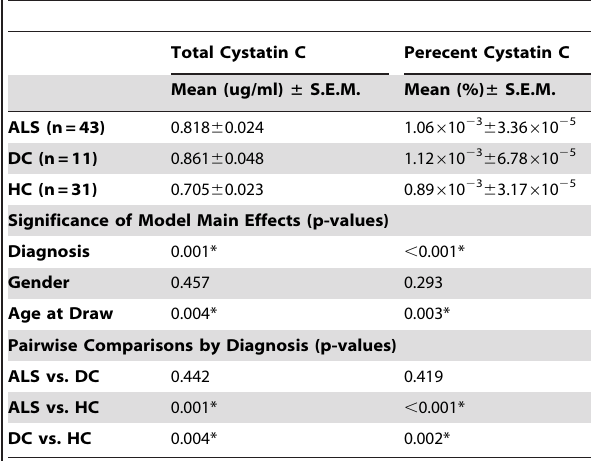
Table 4. Plasma main group results for total and percent cystatin